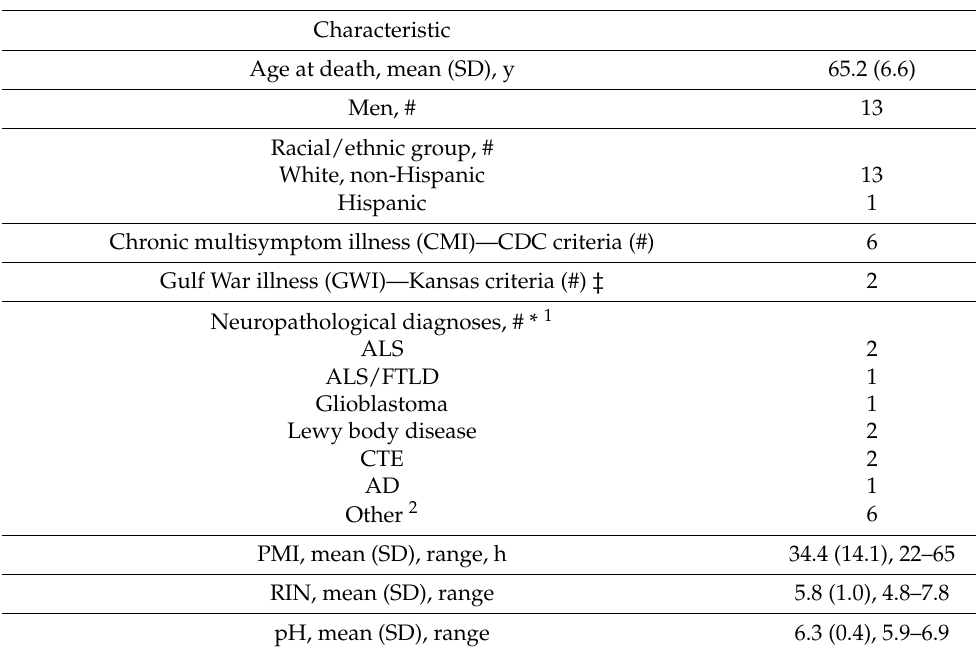
Table 2. Characteristics of the GWVIB tissue